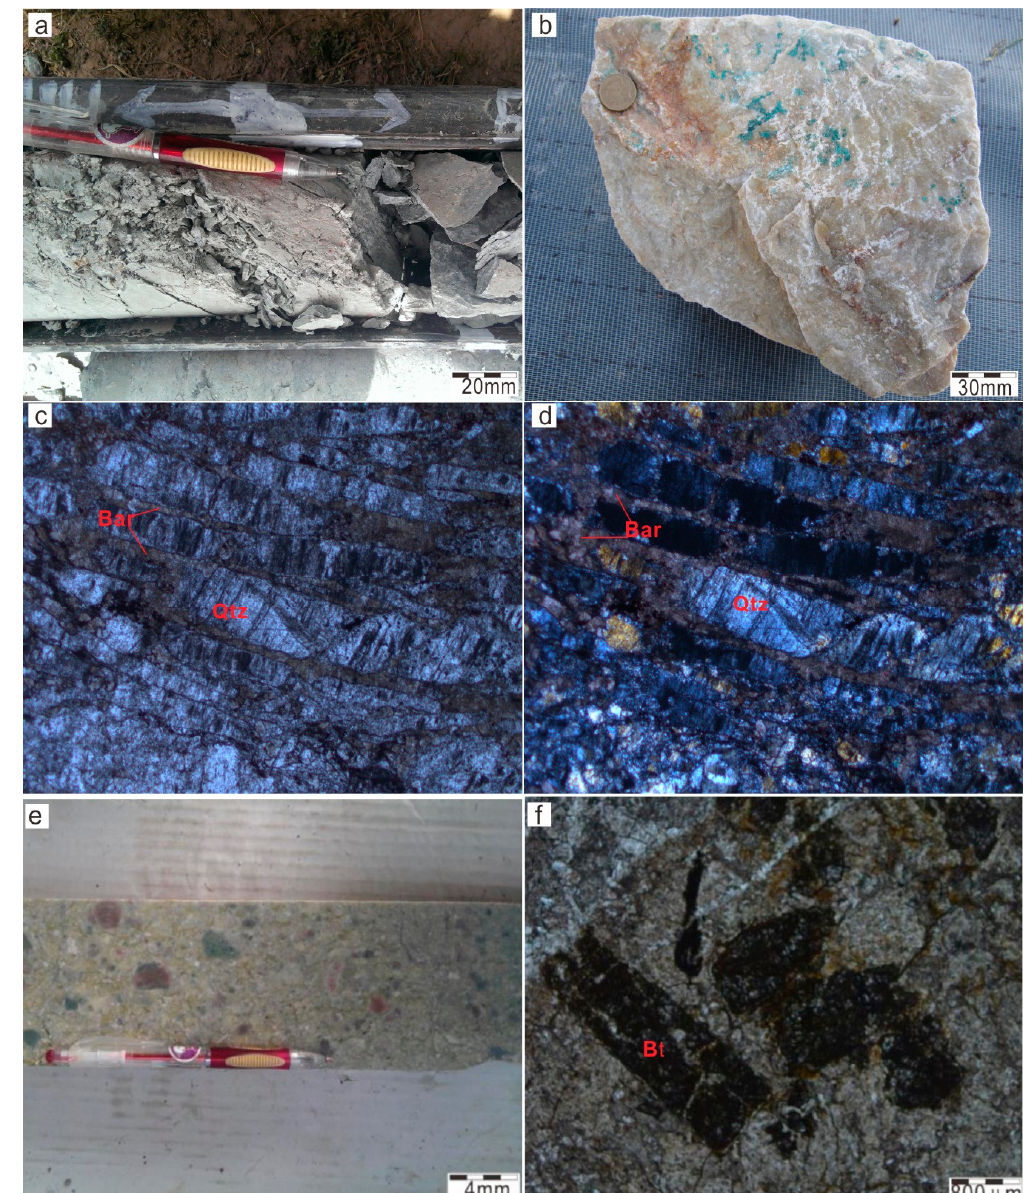
Figure 3. Petrographic photo of ore-hosting rocks in the Kengdenongshe polymetallic deposit. ( a ) field photos of ore-hosting fractured zone and ( b ) ore-hosting barite; ( c ) photomicrographs under plane-polarized light and ( d ) cross-polarized light of quartz-bearing barite veins; ( e – f ) photomicrographs of ore-hosting rhyolitic tuff. Bar: barite; Bt: biotite; Py: Pyrite; Qtz: Quartz.